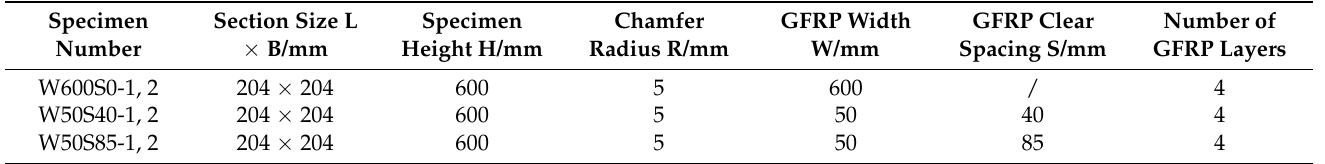
Table 1. Parameters of the composite column specimens.